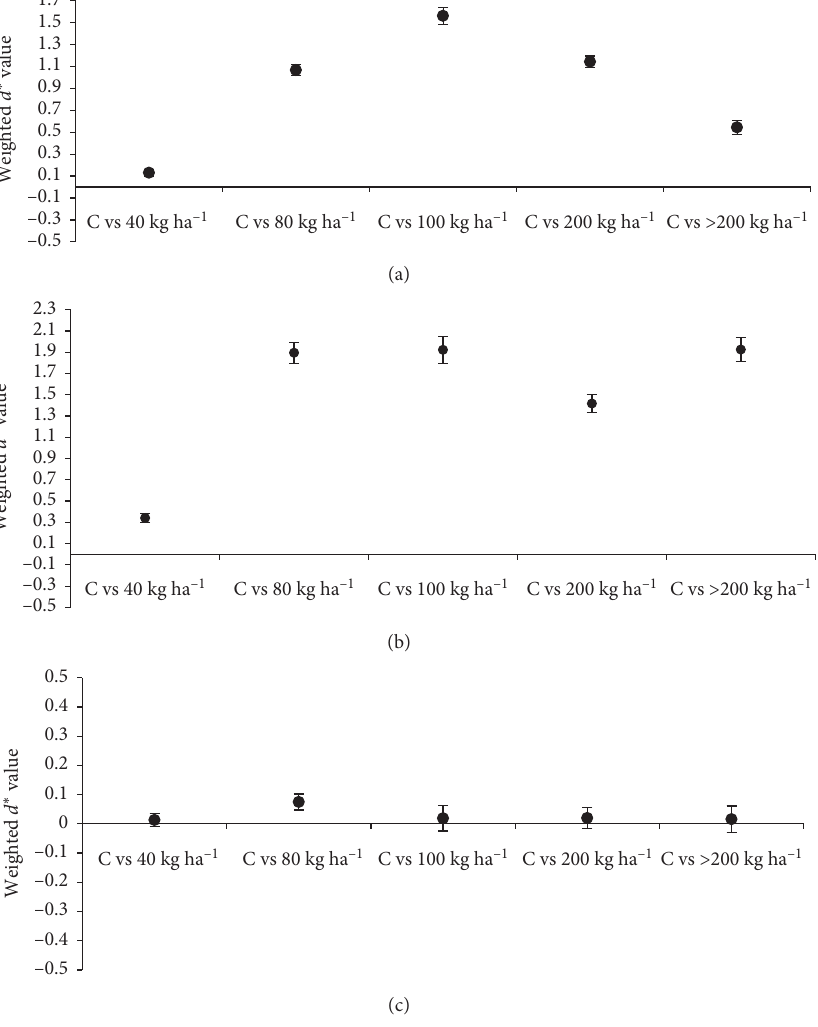
Figure 3: Comparison of the effect of different levels of superabsorbent application on (a) seed yield, (b) dry matter yield, and (c) harvest index of studiedcrops.Barsindicatetheconfidenceintervalsoftheweightedcumulativeeffectsizeamongtheinvestigatedexperiments(Cdenotesthecontrol).